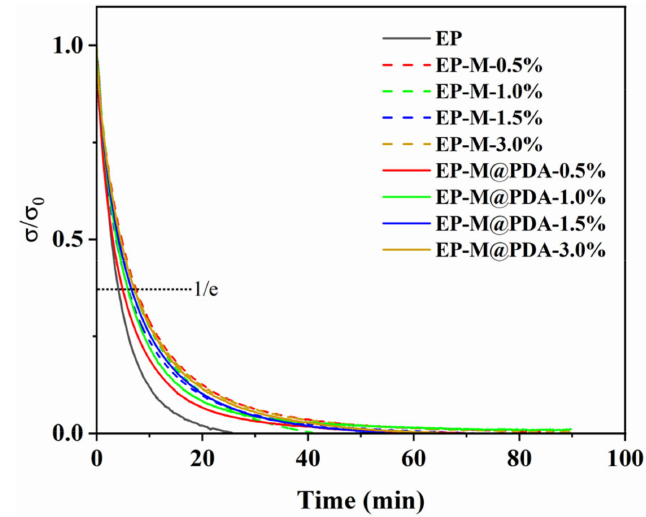
Figure 9. Stress relaxation curves of epoxy vitrimers at 180 ◦